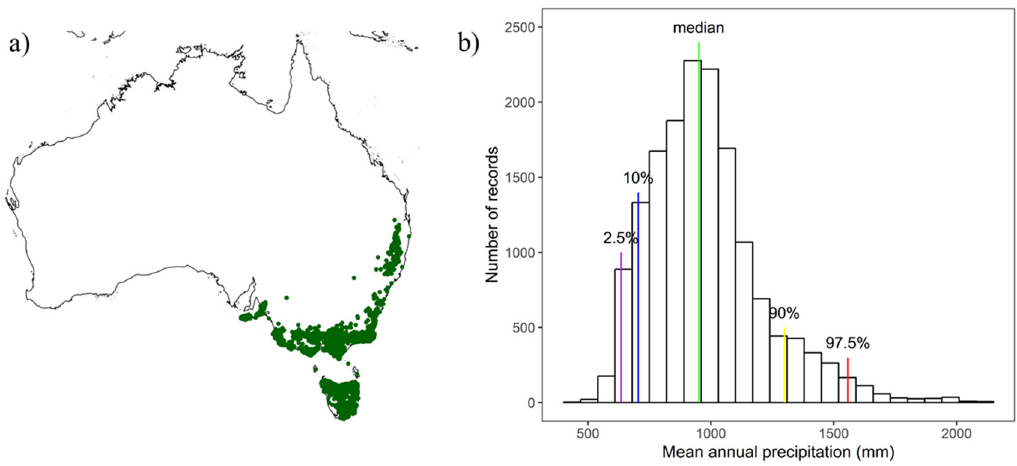
Figure 2. Geographical distribution ( a ) and precipitation envelope ( b ) with key quantiles (coloured lines) of Eucalyptus obliqua (Source: Atlas of Living Australia, Records: 33,964, Downloaded: 12 April 2019).